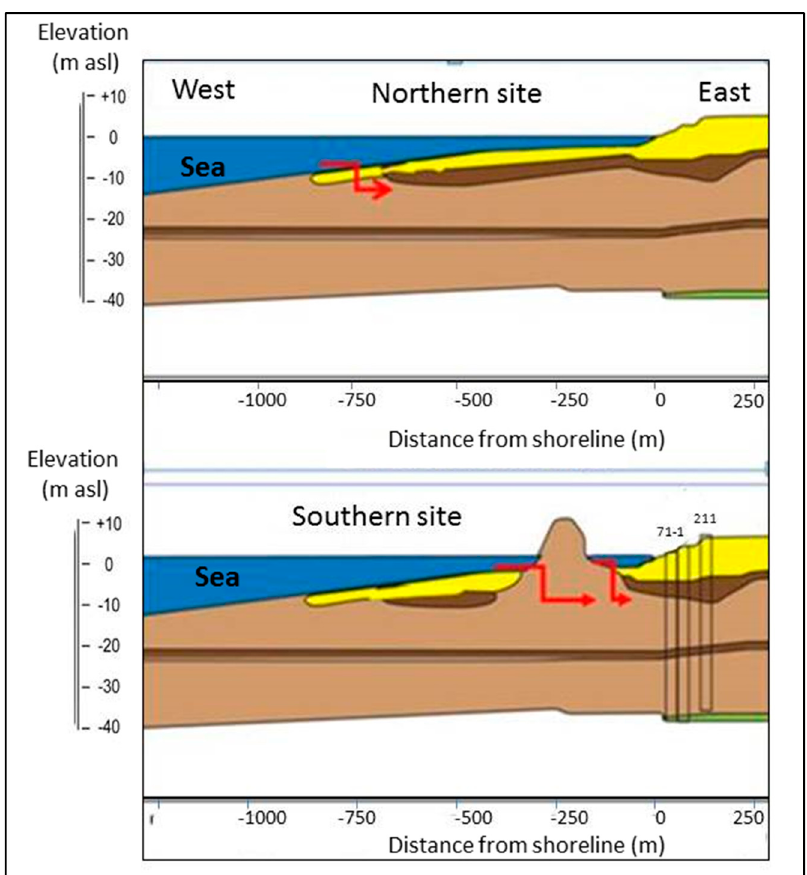
Figure 9. Schematic geological section in the northern and southern sites. In the southern site, the clay is eroded near the shore (100 m), therefore, the Kurkar unit is in direct contact with the sea closer to shore.